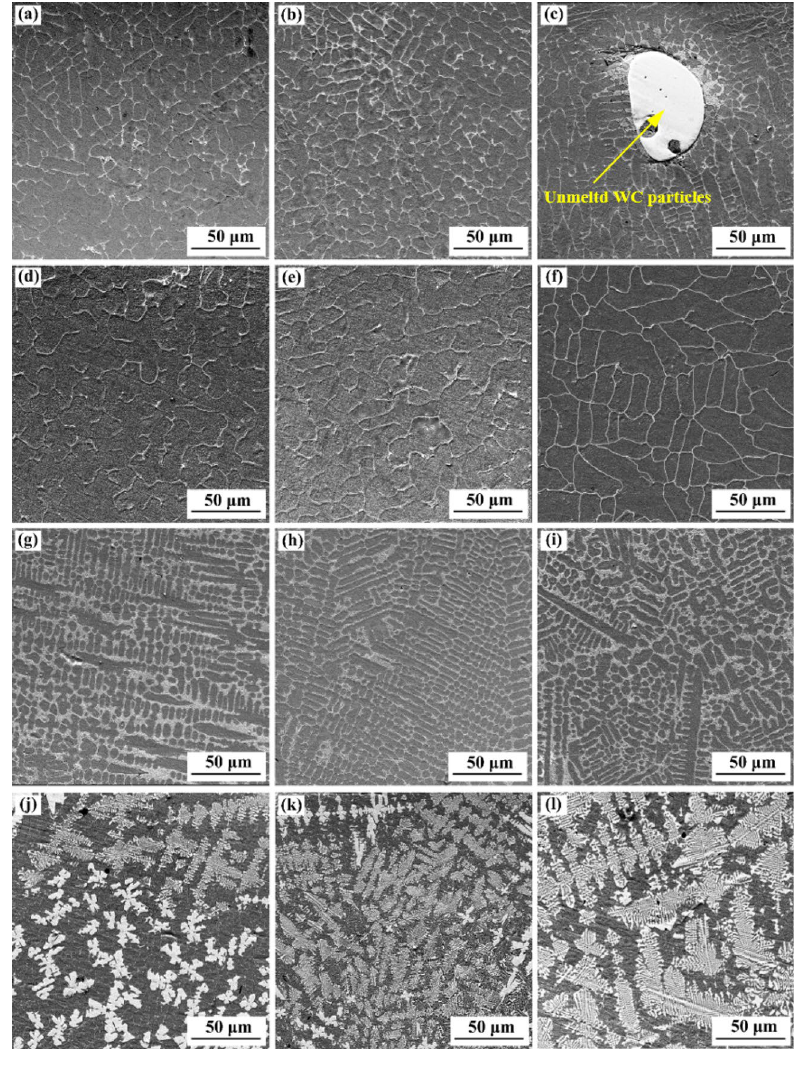
Figure 8. SEM morphologies of different specimens: ( a ) top part of S1; ( b ) middle part of S1; ( c ) bottom part of S1; ( d ) top part of S2; ( e ) middle part of S2; ( f ) bottom part of S2; ( g ) top part of S3; ( h ) middle part of S3; ( i ) bottom part of S3; ( j ) top part of S4; ( k ) middle part of S4; ( l ) bottom part of S4.